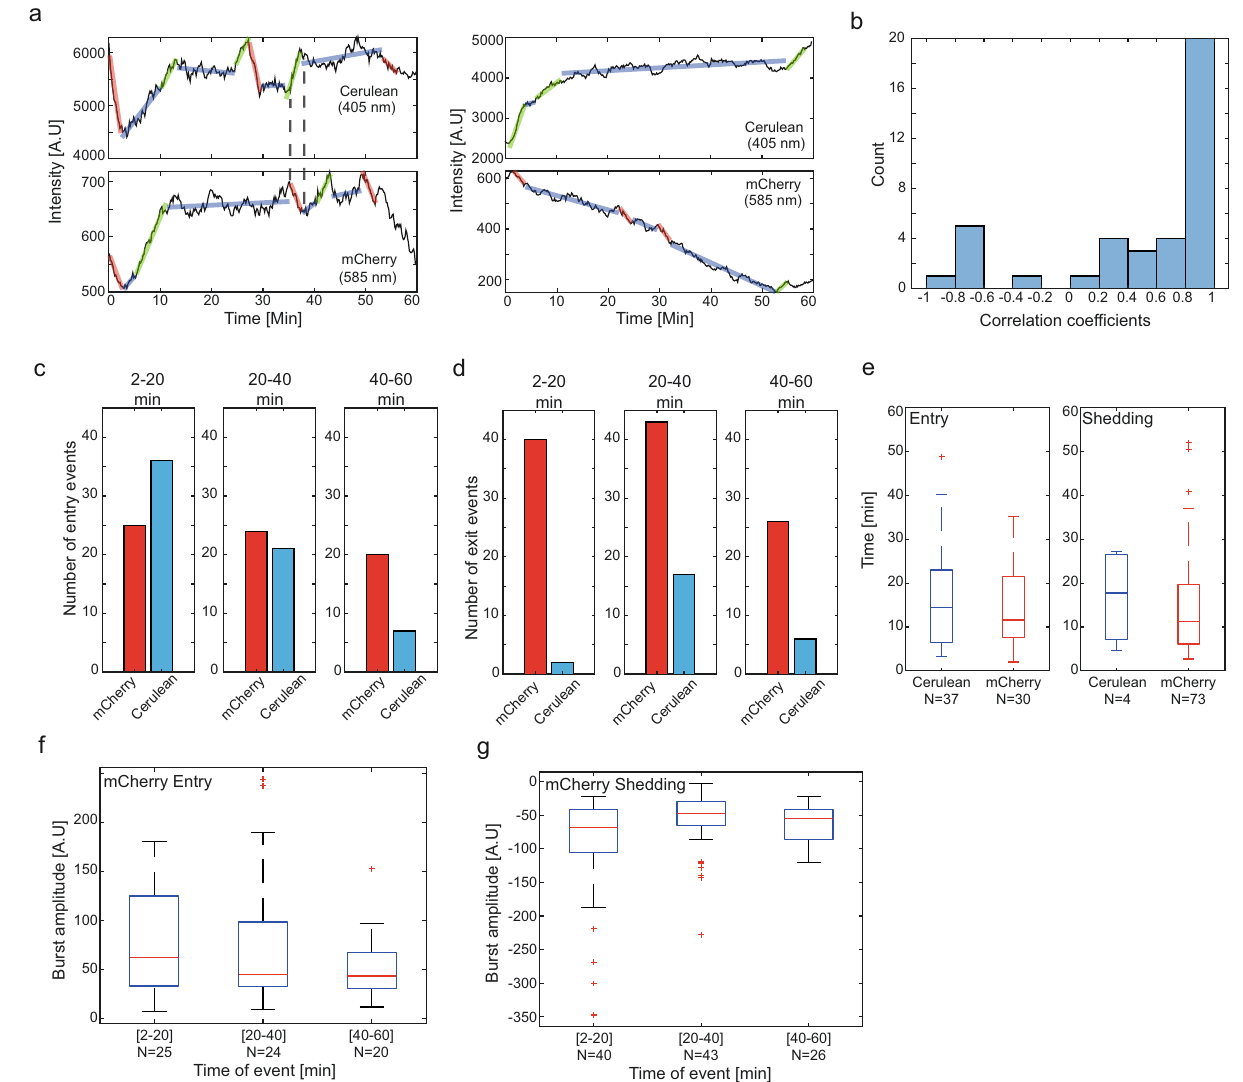
Fig.4|Competitionexperimentsprovidessupportthatgranulationisaliquid- gelphase transition. a Sample traces ofcerulean fl uorescence(top) and mCherry fl uorescence (bottom), showing correlation (left) and anti-correlation (right) between the signals. b Pearson correlation distribution plot computed for the 39 co-labeled tracks. Number of entry ( c ) and shedding ( d ) events for both channels for different tracking intervals: (left) 2 – 20 ’ , (center) 20 – 40 ’ , and (right) 40 – 60 ’ . e Boxplots depicting distributions of durations between an entry events (left),and durations between shedding events (right), for cerulean fl uorescence (blue). Burst